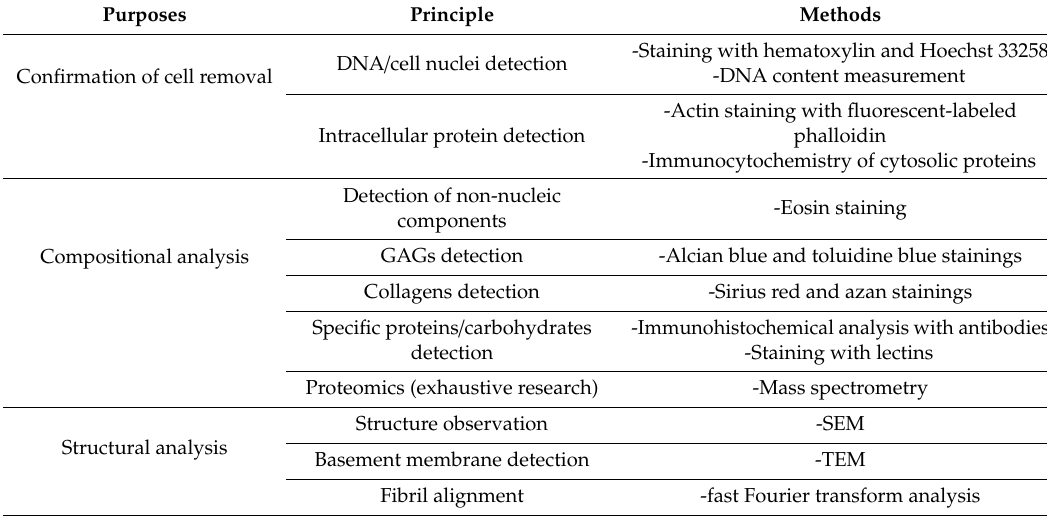
Table 2. Frequently used characterization methods of